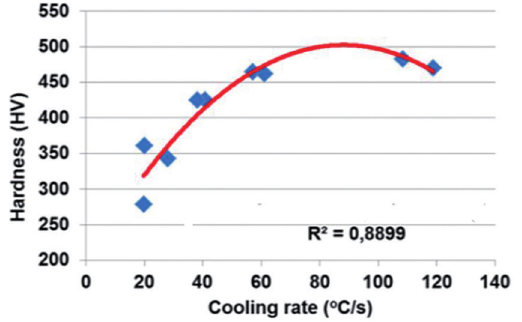
Figure 13: Correlation of hardness with cooling